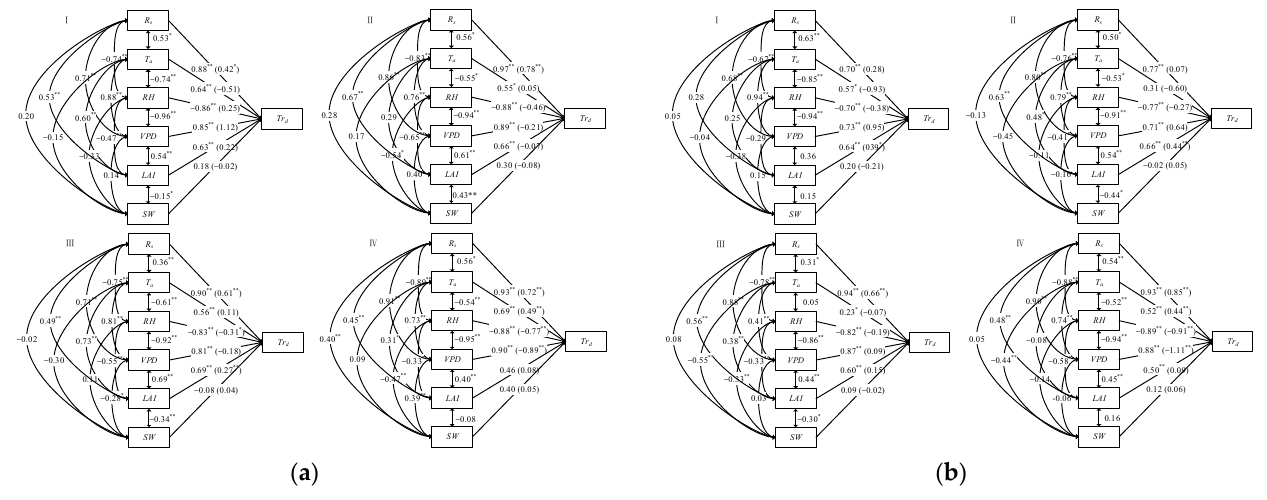
Figure 6. Path analysis results of instantaneous transpiration and meteorological factors in each growth period. ( a ) 2020; ( b ) 2021. I, II, III, and IV respectively represent the new growth period, flowering and fruit setting period, fruit expansion period, and fruit maturation period. * Indicates significant correlation between independent variable and dependent variable ( p < 0.05); ** Indicates highly significant correlation between independent variables and dependent variables ( p < 0.01). Table 2. Path analysis results of transpiration and factors at different time scales in the whole growth